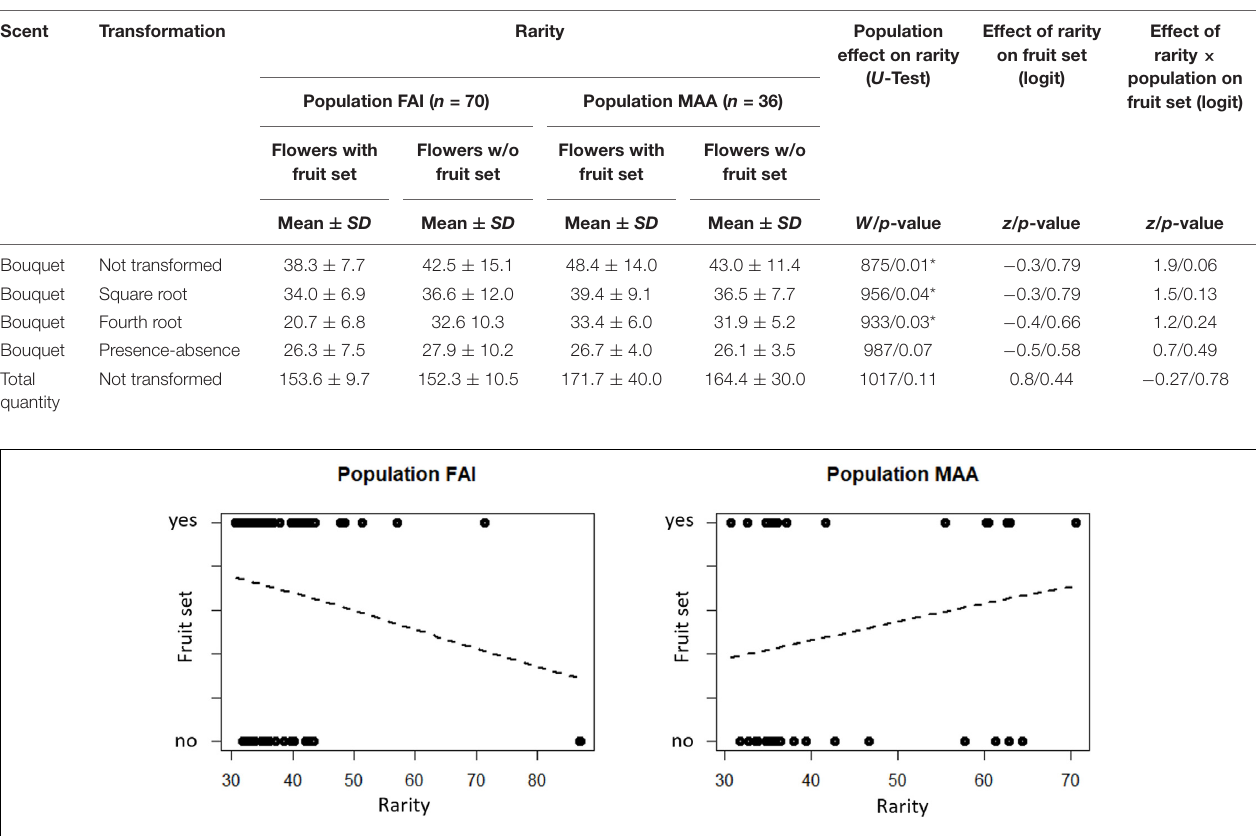
FIGURE 1 | Non-metric multidimensional scaling (NMDS) to visualize semi-quantitative dissimilarities between the individual scent samples taken in the two investigated populations (FAI, Faistenau; MAA, Maria Alm). This ordination is based on pairwise Bray-Curtis similarities. In (A) , symbols of scent samples whose flowers have been pollinated are filled, while those of unpollinated flowers are unfilled. (B) is the same ordination as (A) , here, however, the calculated rarity of the single samples is indicated, with the sizes of the circles being proportional to the rarity of the samples. TABLE 1 | Mean ( ± SD ) rarities in various scent properties (non-transformed, square and fourth root transformed relative scent bouquet; presence-absence of compounds; total absolute amounts of scent trapped) of individuals that set fruits and individuals that did not set fruits of two different populations (FAI, Faistenau; MAA, Maria Alm). Rarity values differ between the populations for relative amounts and their square and fourth root transformations, but not for qualitative data and total quantity of scent. Results of logistic regressions (logit) indicate that rarity does not influence fruit set in any of the scent trait analyzed. Since there is no interaction effect with population, influence of rarity on fruit set is not different among the two populations.